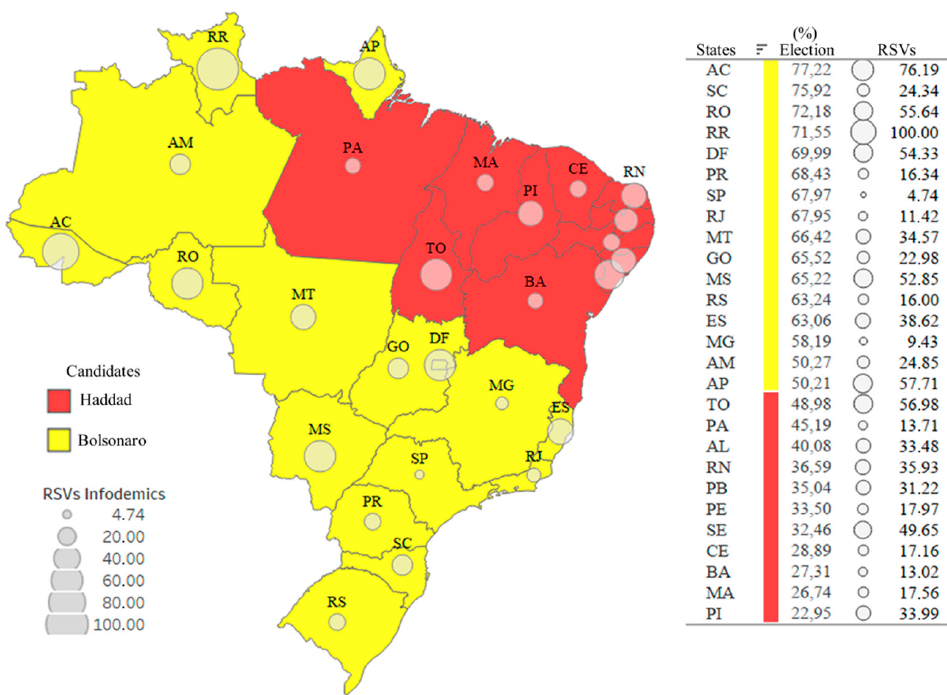
Figure 5. Spatial distribution: Infodemic RSVs and 2018 presidential elections.